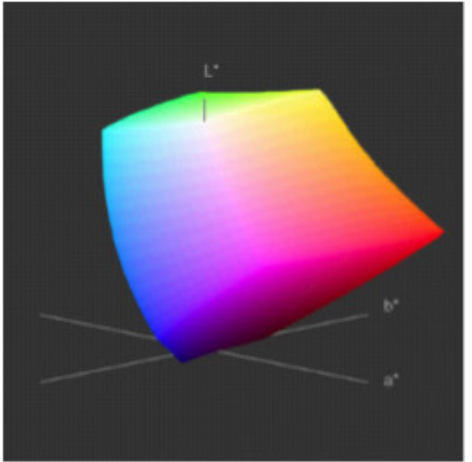
Figure 3: A visualization of the three-dimensional CIE Lab col - our space. (Courtesy of G. Hoffmann 22 ). Note how the perceiv - able colour gamut decreases at very high luminance (L*) levels and especially at low luminance